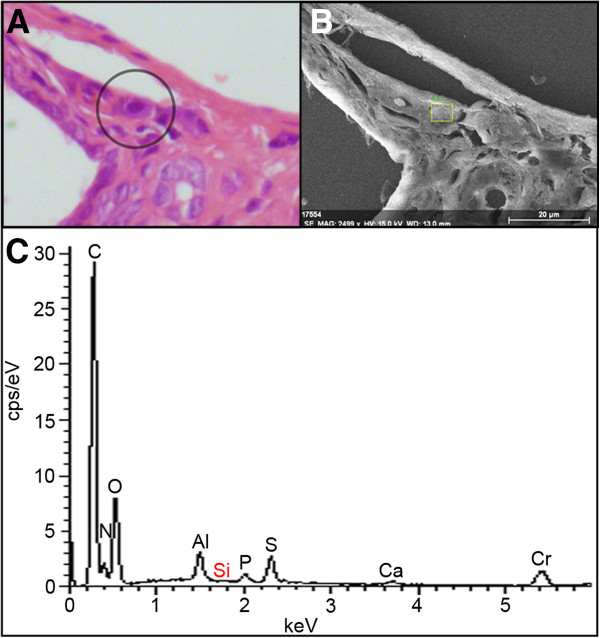
Histological and electron microscopical images from the liver. (A) Light microscopic image of a macrophage (indicated by the circle) in liver tissue from an animal treated with the highest dose of SAS for 84 days, and (B) a corresponding SEM-EDX graph of the same macrophage (indicated by the rectangle) in which (C) the elemental composition was analyzed.